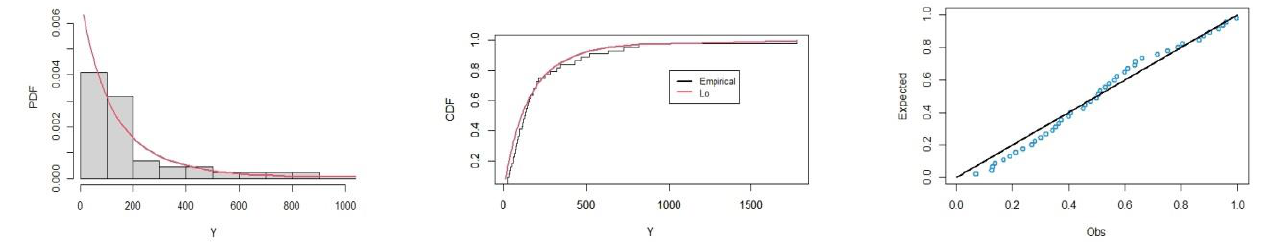
Figure 8. Estimated PDF, CDF, and PP plots of the Lo distribution for Y.